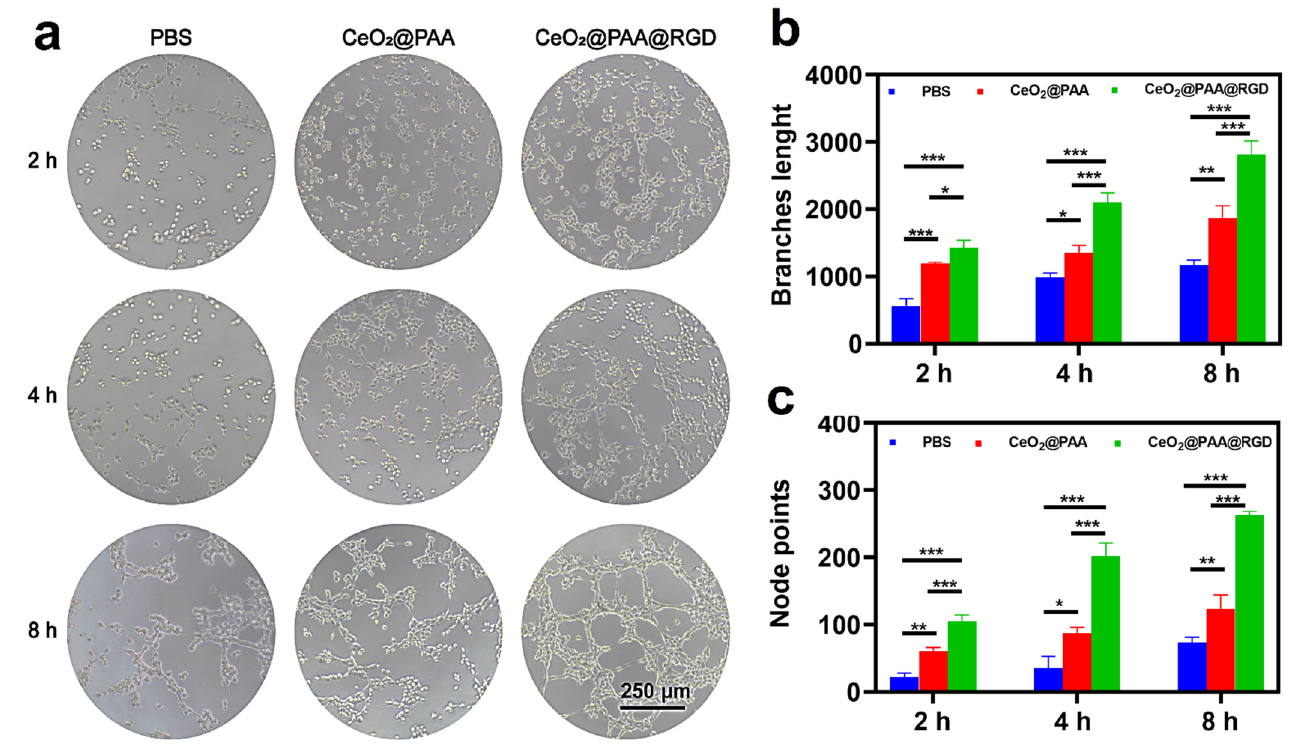
Figure 5. Angiogenic effect of HUVEC cells observed by microscopy. ( a ) Microscopic photomicro- graphs were used to observe the effect of angiogenesis in HUVEC cells after treatment with PBS, CeO 2 @PAA, and CeO 2 @PAA@RGD for 2 h, 4 h, and 8 h (scale bar = 250 µm); quantitative meas- urement of the branch length ( b ) and node points ( c ) ( n = 3) after treatment of HUVEC cells with PBS, CeO 2 @PAA, and CeO 2 @PAA@RGD nanoparticles at 2 h, 4 h, and 8 h. Error bars = mean ± standard deviation (SD) ( n = 3); * p < 0.05, ** p < 0.01, *** p < 0.001, using a one-way ANOVA (and nonparametric or mixed).